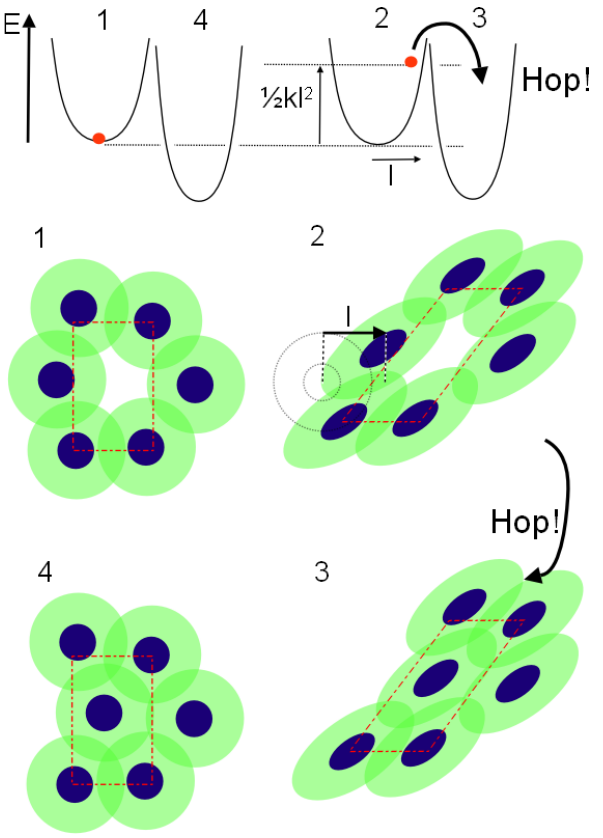
Figure 5: Schematic showing the hop and trap model for the ar- rangement of calcium – protein assemblies showing and analogous energy wells, adapted from Fielding et al. [49]. The schematic is int- edended to be read clockwise, 1) local arrangement is meta stable, but diffusion from 1 to 4 is impossible. 2) Apply a strain decreases the remaining barrier height required for rearrangement. Diffusion into state 3 is possible with suflcient time. 3) Protein-calcium as- semblies rearrange into a new energy well. 4, The applied strain is removed but rearrangements imply not all strain is recovered.